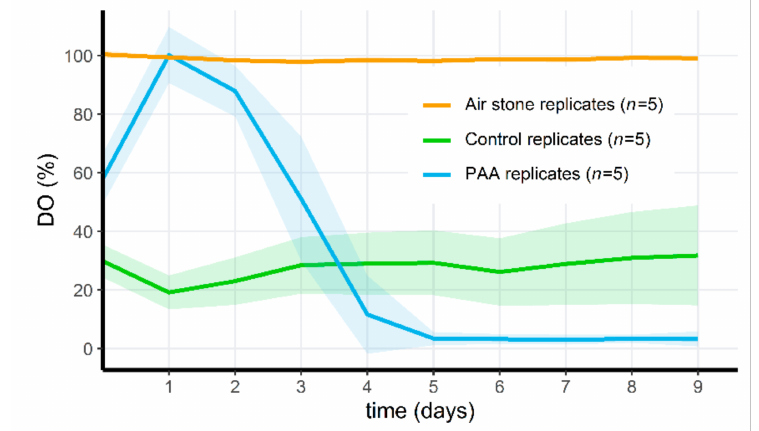
Figure 6. Mean dissolved oxygen (%) through time per treatment group for the second microcosm experiment. Shaded areas indicate mean ± standard deviation. Orange data is obtained from repli- cates that had an air stone and were treated with PAA, blue data is from the replicates that did not have an air stone and were treated with PAA, green data indicates results from the control replicates, that did not have air stones and were treated with artificial pond water.